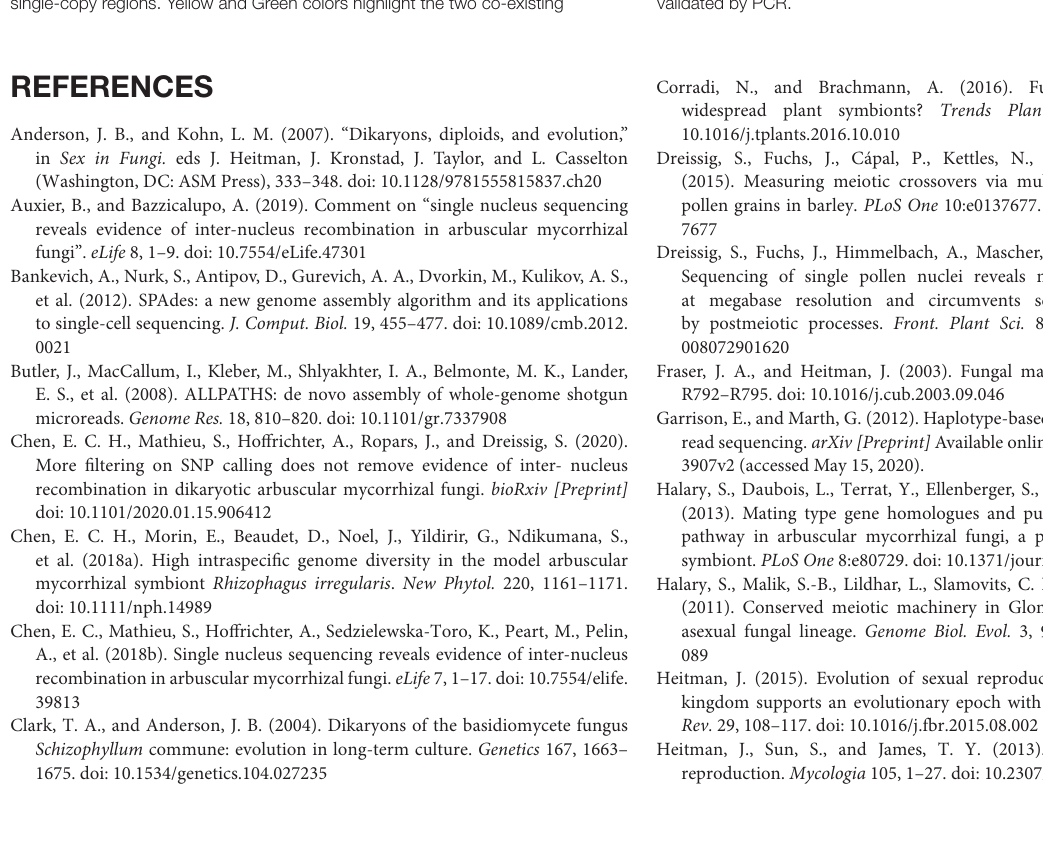
genotypes. Nuclei highlighted in yellow and green had their MAT locus validated by PCR. Nuclei with cells highlighted in light green carry a genotype that is mostly associated with green nuclei validated by PCR, while those with cells highlighted in orange carry a genotype that is mostly associated with yellow nuclei validated by PCR. TABLE S2 | Recombination blocks (Scenario #2) obtained from genotype file with at least five reads supporting a SNP in the first 1000 contiguous. Based on Supplementary Table S1 . TABLE S3 | Confirmation of genotypes found by Ropars et al., 2016 Nature Microbiology using PCR and Sanger sequencing. F (A) = = Reads supporting genotype (reads against genotype). Read depth is shown on the left columns for each position. Numbers in bold represent valid genotypes with very low read depth, i.e., 1 to 5. TABLE S4 | Recombination blocks (Scenario #2) obtained from genotype file with at least two reads supporting a SNP in the first 1000 contiguous. Based on Supplementary Table S5 . TABLE S5 | Genotype file with minimum coverage of 2, with heterozygous sites as defined in Chen et al. (2018b) and Auxier and Bazzicalupo (2019) removed, and based on regions found only once in the reference genome. Yellow and Green colors highlight the two co-existing genotypes. Nuclei highlighted in yellow and green in had their mating-type locus validated by PCR. Nuclei with cells highlighted in light green carry a genotype that is mostly associated with green nuclei validated by PCR, while those with cells highlighted in orange carry a genotype that is mostly associated with yellow nuclei validated by PCR. TABLE S6 | Examples of recombination with high coverage. Nuclei ID are colored for identification purposes. Yellow and dark green MAT -locus that is PCR verified. Yellow and Green colors highlight the two co-existing genotypes. Nuclei highlighted in yellow and green in had their mating-type locus validated by PCR. Nuclei with cells highlighted in light green carry a genotype that is mostly associated with green nuclei validated by PCR, while those with cells highlighted in orange carry a genotype that is mostly associated with yellow nuclei validated by